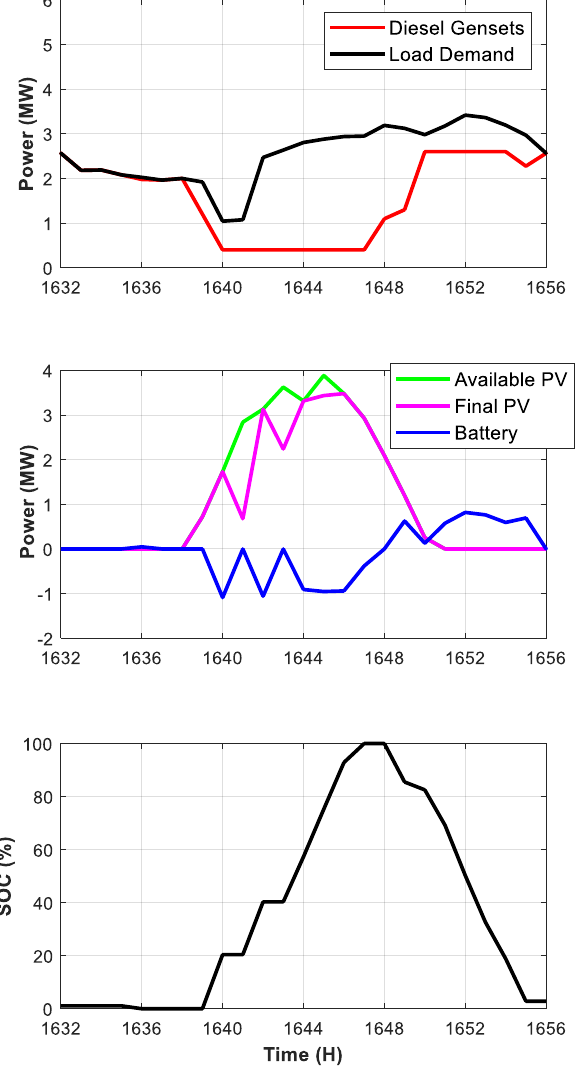
Figure 6. Microgrid operation for one day in summer using the optimal EMS Strategy.